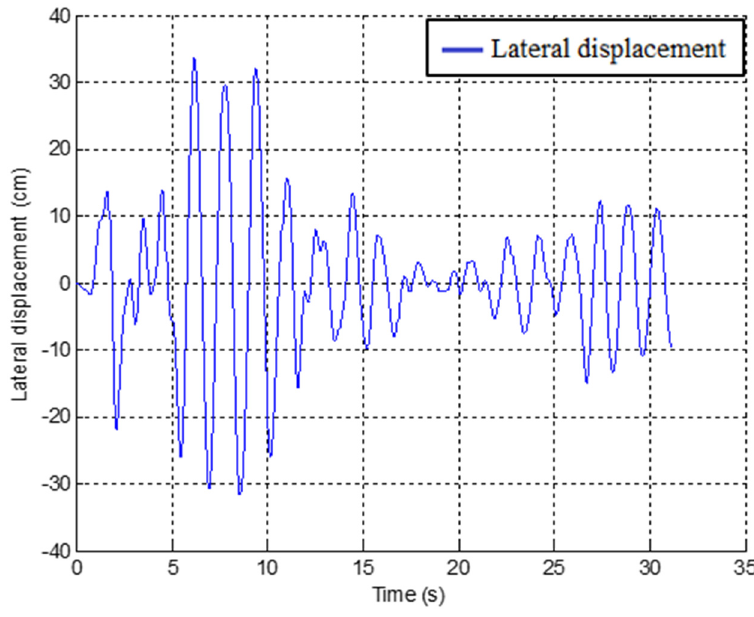
Figure 4. Top lateral displacement time histories of both isolated buildings.